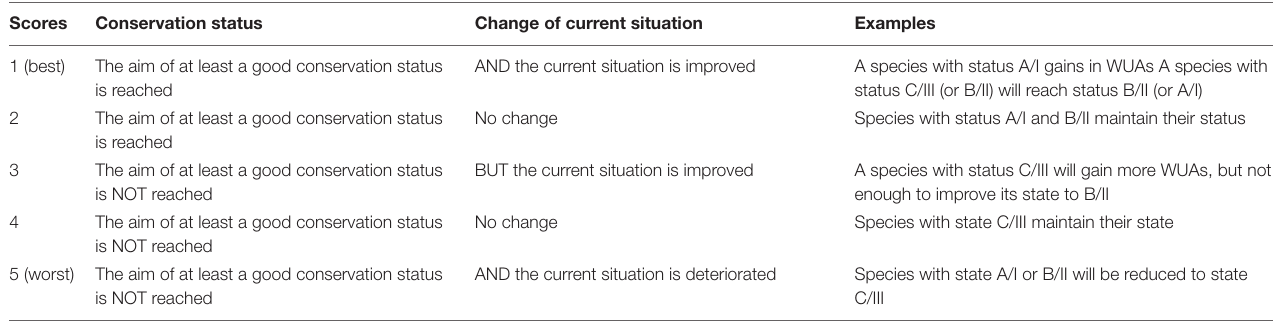
TABLE 2 | Evaluation scheme for the HBDs and nature protection approach for each species based on the respective conservation status and the predicted improvement or deterioration of this status.